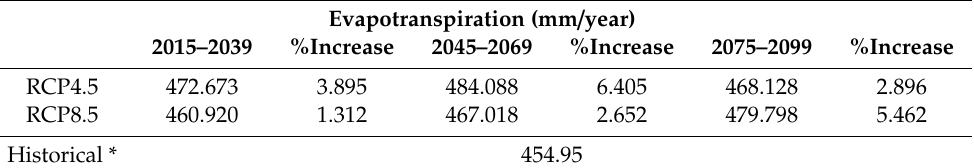
Table 6. Historical and projected ET rates under both scenarios and the percentages of increase from the present.